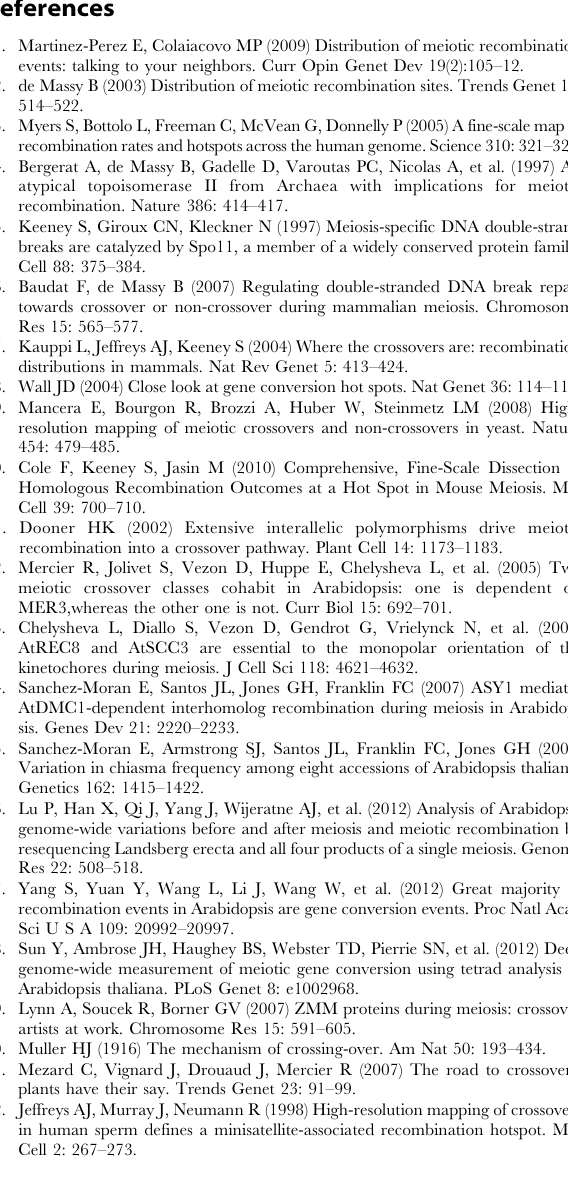
circles along the chromosome coordinate axes. Triangles: insertion or deletion above 7 nt. Thick red or blue horizontal lines: converted SNPs, Thick grey dotted horizontal lines: interval in which NCO tract ends are located. Blue: Col; Red: L er . Yellow line: chimeric SNPs. Figure S4 Chiasma number per meiosis in ‘‘MSH4’’ and ColxLer F1s. The number of chiasma per male meiocytes was obtained as described in [15]. Number of cells = 40 for each F1. File S1 R Script to determine the parameters of the best fitting Gaussian distribution of a CO distribution. Table S1 Sequences of primers. Table S2 Primers for DNA quantification and CO detection.